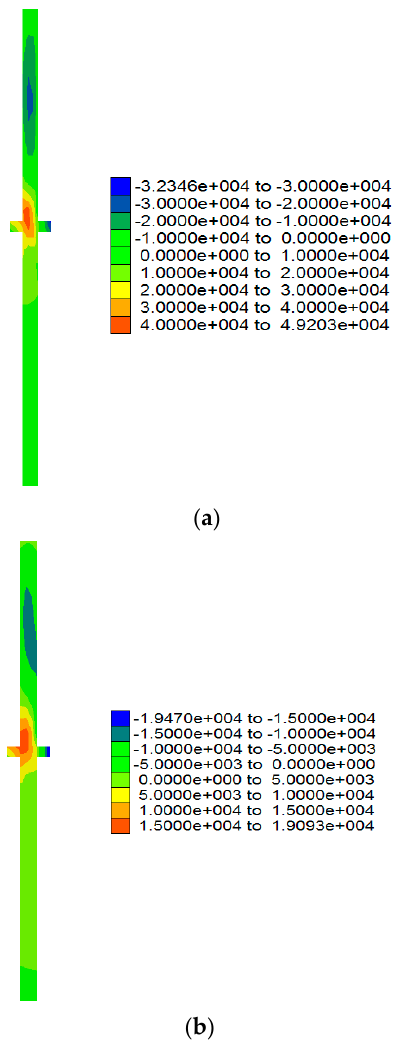
Figure 22. Comparison of shear stress distribution on YZ plane of cut-off l at monitoring surface. ( a ) 1. ( b ) 2.